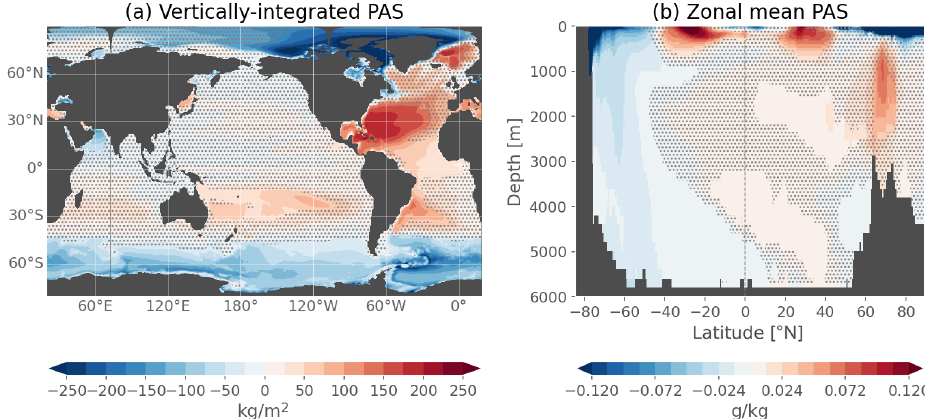
Figure 16. Vertically integrated (a) and zonal mean (b) passive anomaly salinity in years 2040–2059 of the CTL simulations. Stipples indicate where the value is lower than twice the interannual standard deviation of the salinity in the CTL